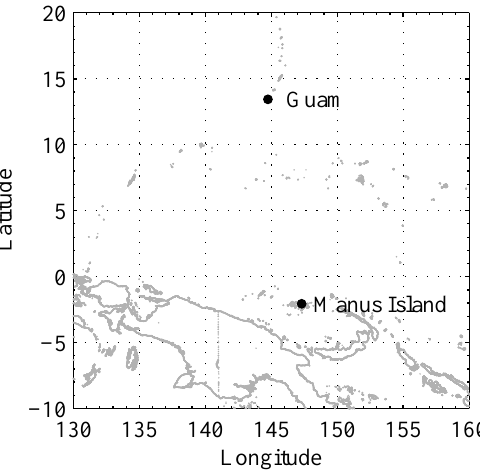
Figure 1. Map of the experimental area, with Manus and Guam